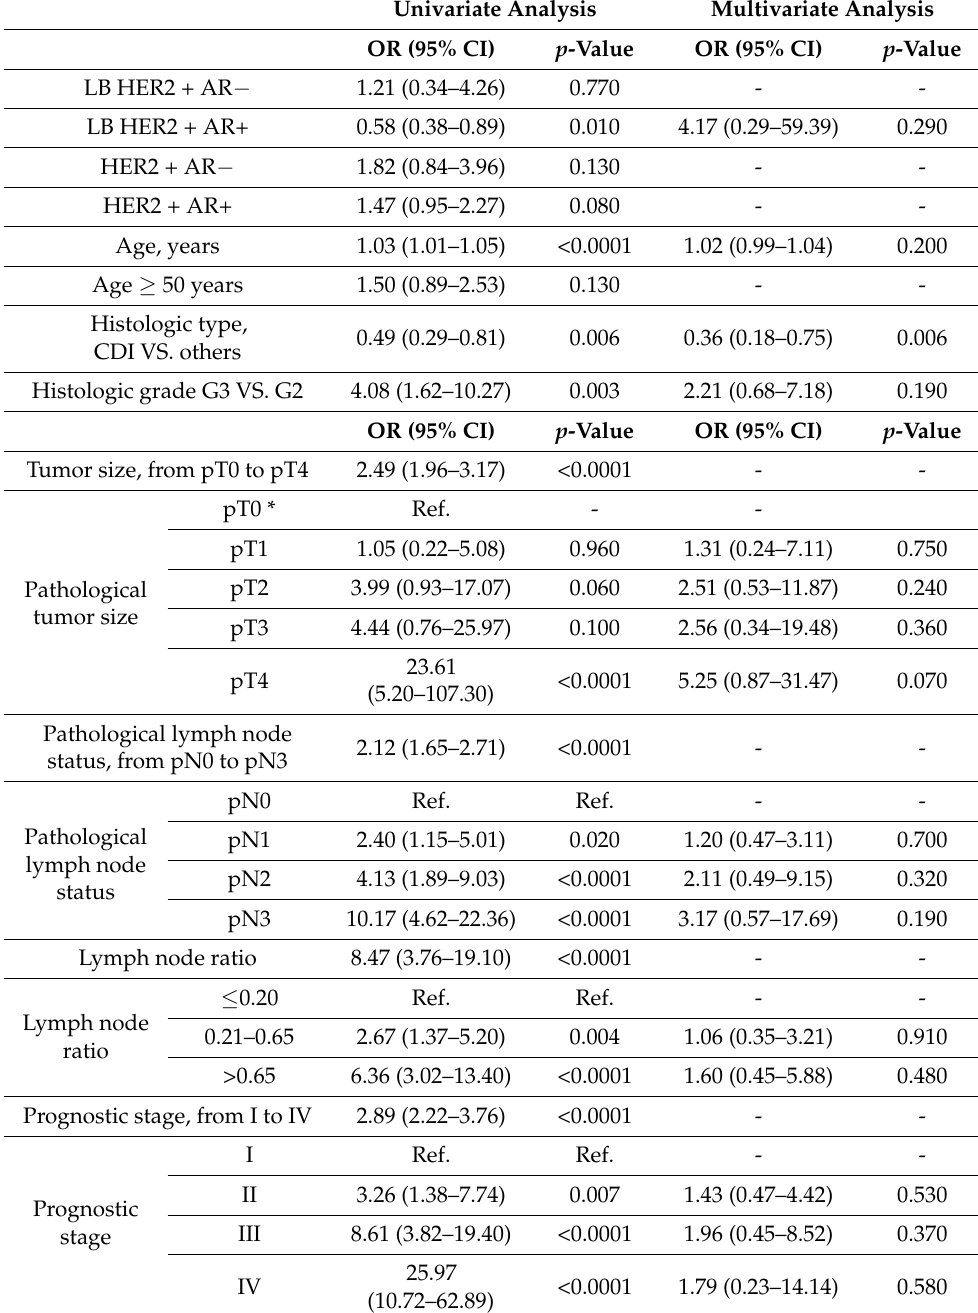
Table 5. Univariate and multivariate analysis for overall survival in HER2-positive breast cancer. Univariate Analysis Multivariate